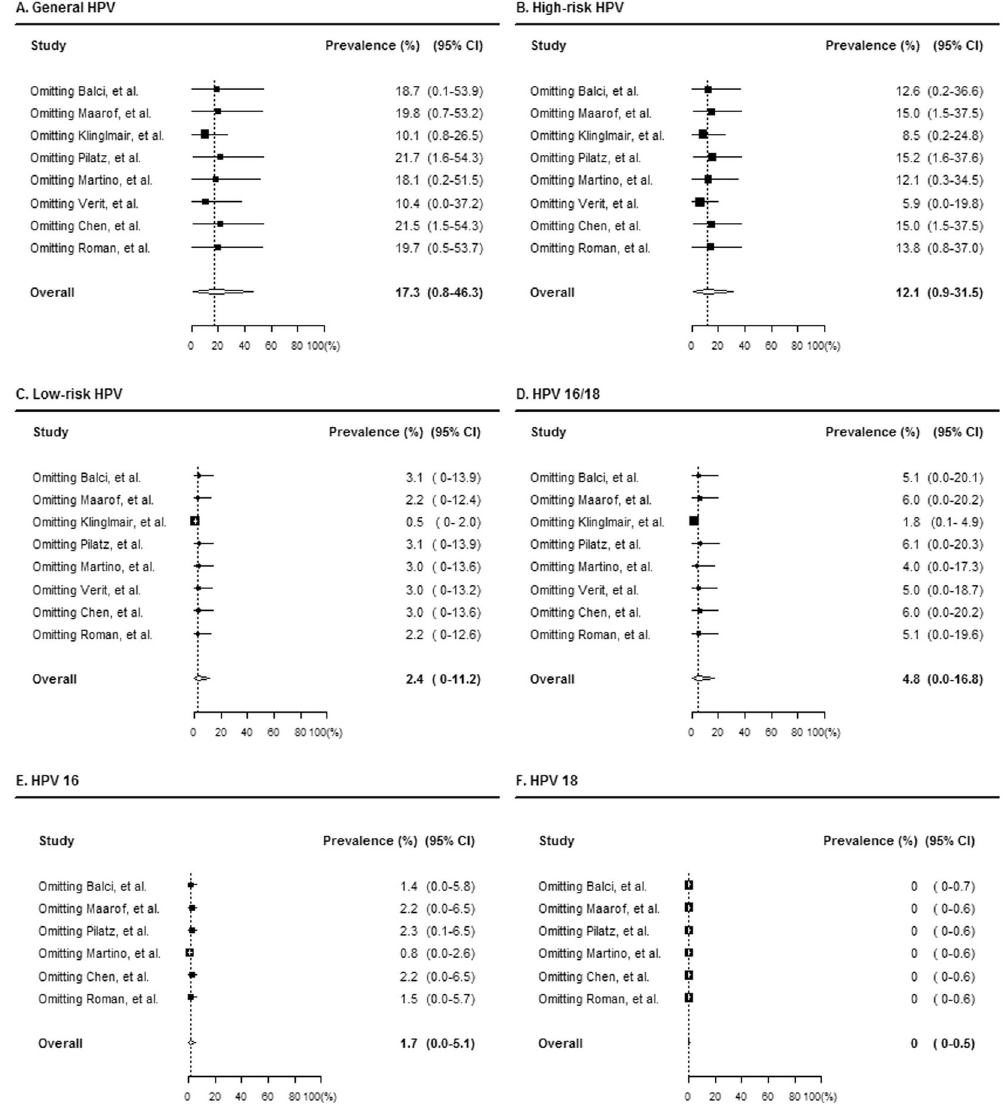
Figure 3. Influential analysis of the prevalence of PCR-detected HPV infection. Forest plot diagram showing the pooled estimate for HPV prevalence after the exclusion of the relevant studies for each type on general HPV ( A ), high-risk HPV ( B ), low-risk HPV ( C ), HPV 16/18 ( D ), HPV 16 ( E ), and HPV 18 ( F ). The black square signifies the weighted mean of each estimate. All data provided are for continuous